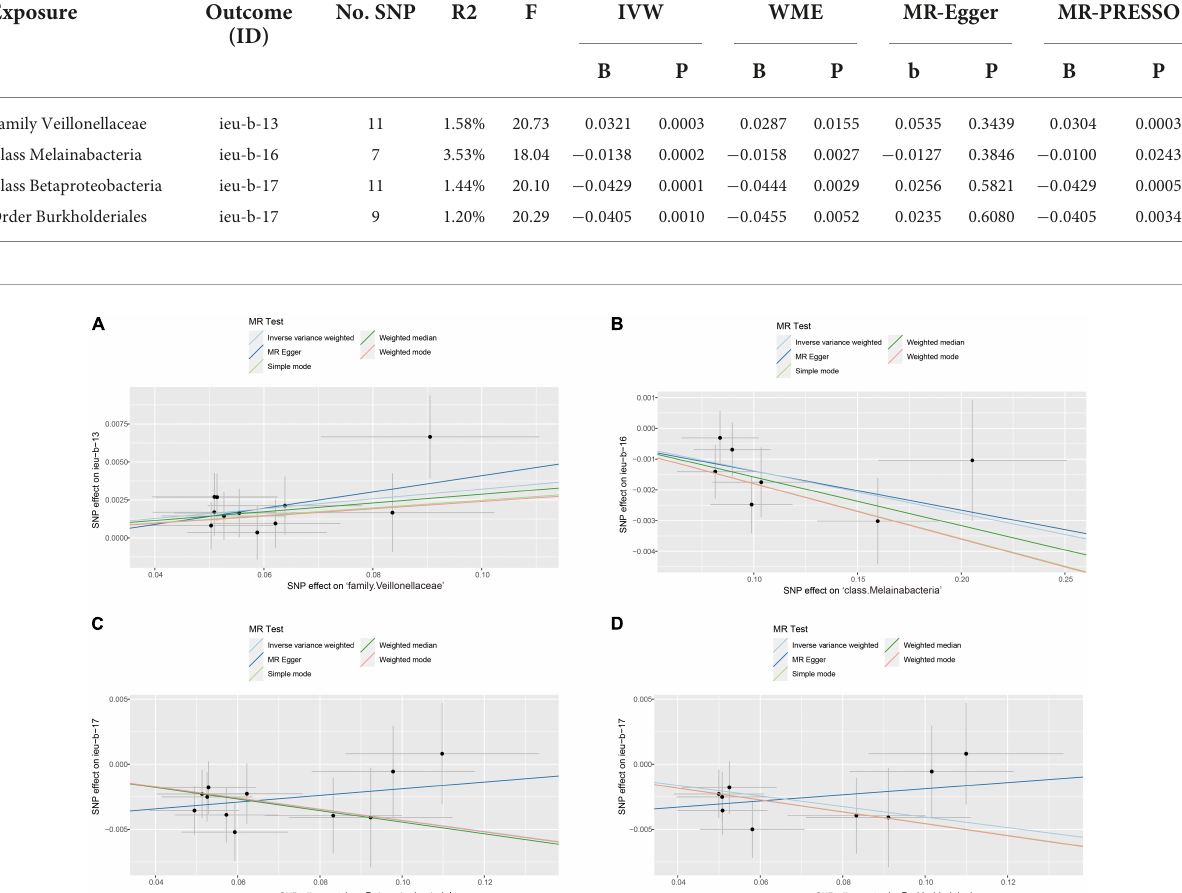
TABLE 2 Gut microbiota on epilepsy result.